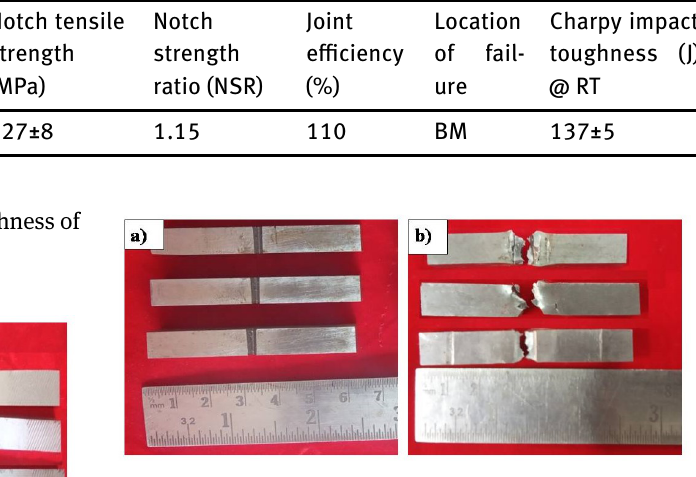
Table 4: Transverse tensile properties and impact toughness of welded joint.